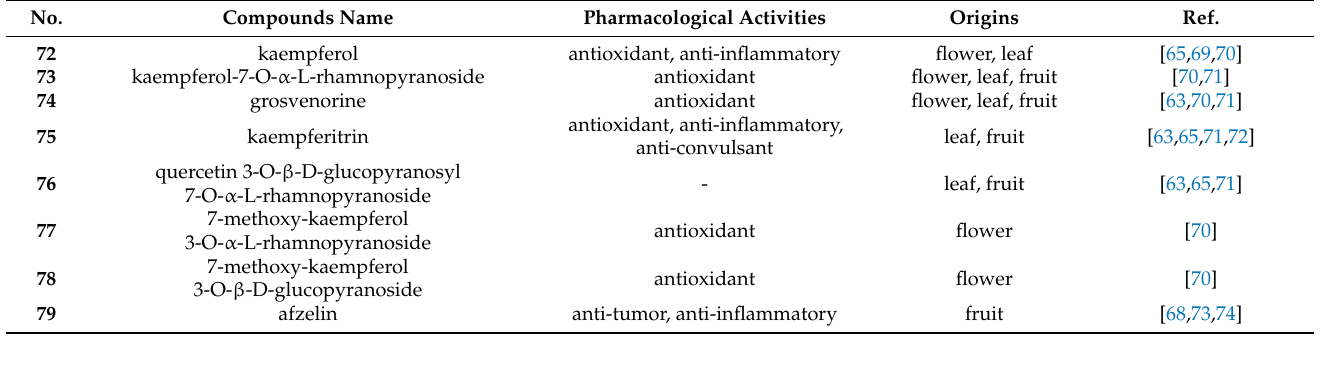
Table 2. Flavonoids isolated from S. grosvenorii .